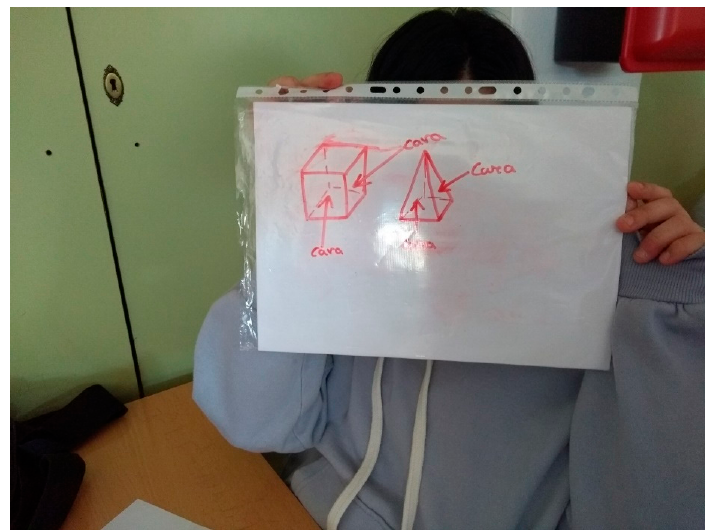
Figure 7. ( a ) wooden geometric bodies; ( b ) student classifying geometric bodies.